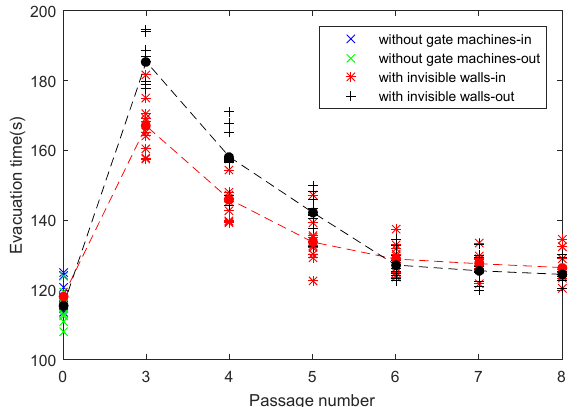
Figure 12. Comparison of crowd entry and exit times with different numbers of